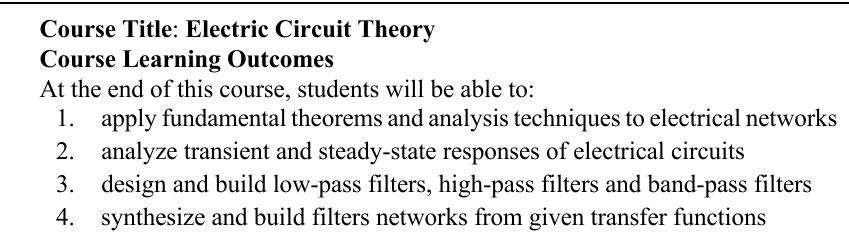
Fig. 8. A Sample of Learning Objective for Electric Circuit